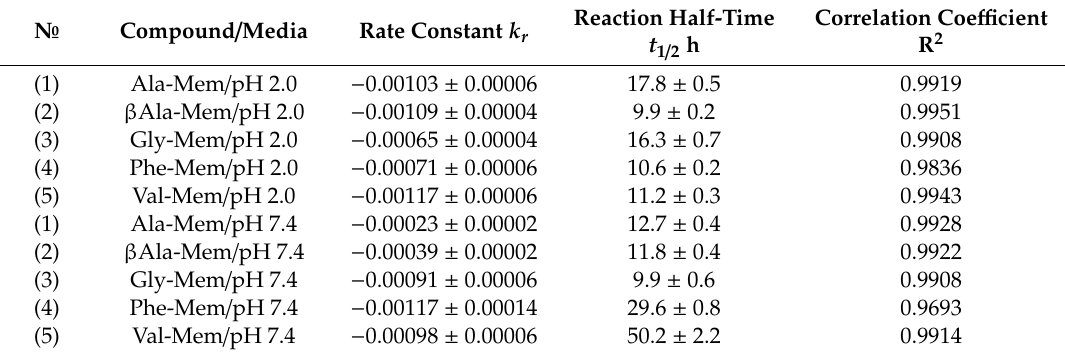
Table 2. Rate constants for degradation processes of memantine analogues, reaction half-times and correlation coe ffi cient of the regression line in coordinates ln ( C / C 0 ) vs. t . All experiments were carried out at 37 ◦